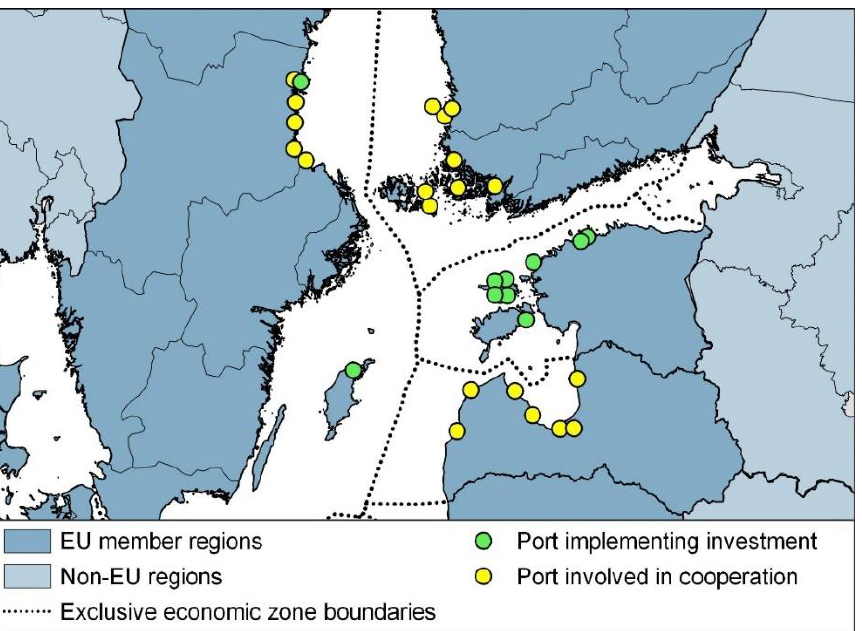
Figure 19. Energetic small ports in the central Baltic region cooperation network. Source: own study based on [80].